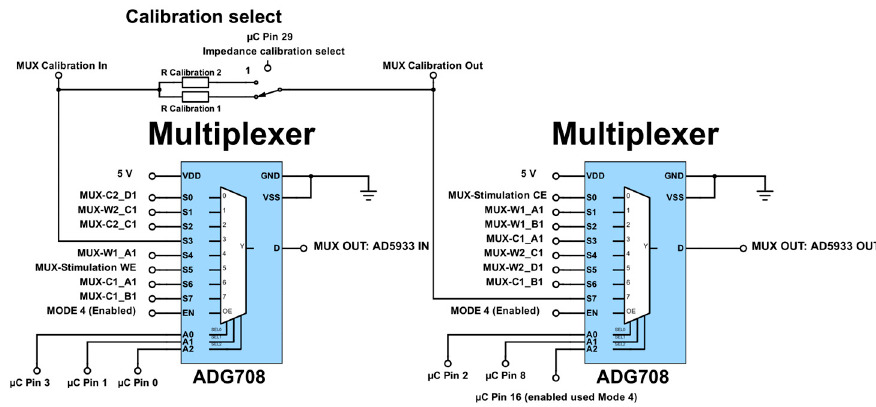
Sensors 2017 , 17 , 59 Figure 6. Circuit schematic showing the source multiplexing and the calibration resistance selection. Analog switch inputs A0 to A2 allow the different electrode configurations for the impedance measurement. Designation 1 and 2 correspond to the working and counter electrode, respectively.